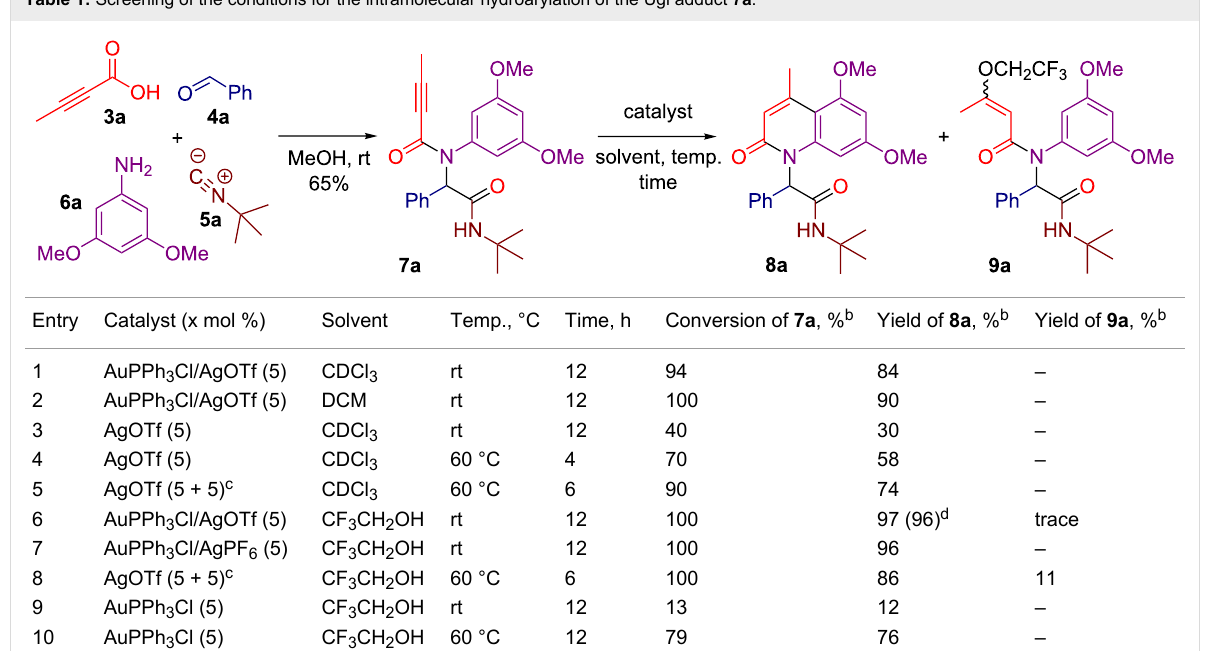
a Reaction conditions: 7a (0.2 mmol), solvent (2 mL), under air. b Determined by 1 H NMR using 3,4,5-trimethoxybenzaldehyde as an internal standard. c The first portion of catalyst was added at the beginning of reaction, while the second portion was added after 3 h. d Isolated yield for a 0.5 mmol